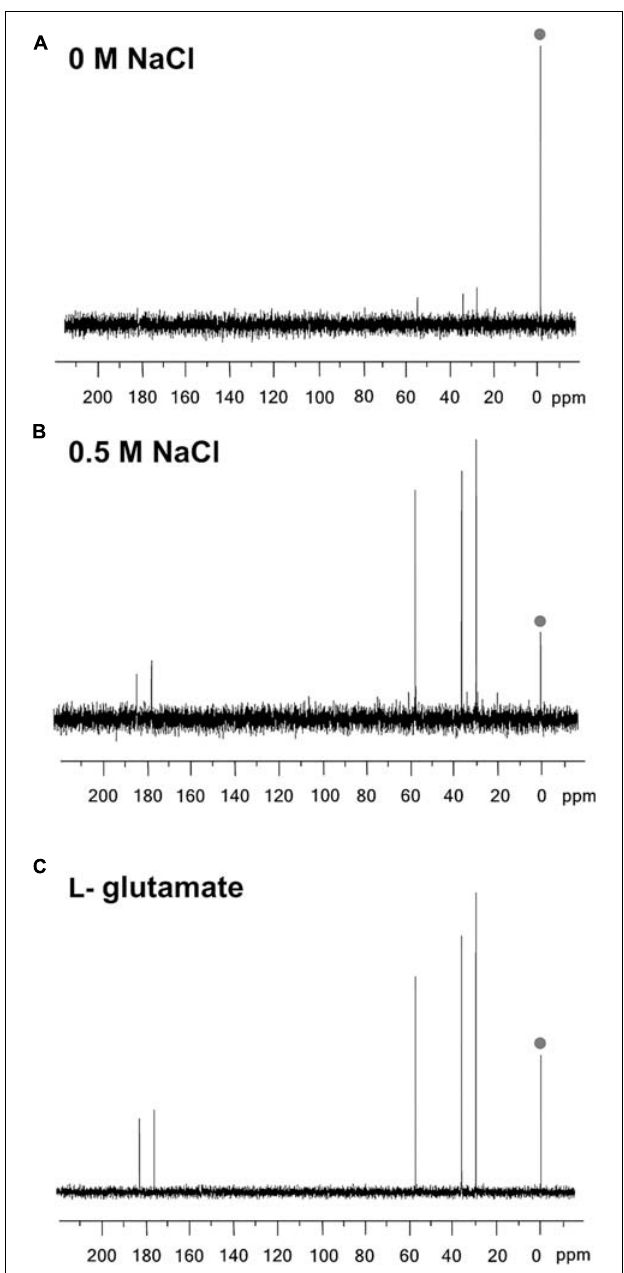
FIGURE 2 | 13 C NMR spectra of ethanolic Bacillus methanolicus MGA3 cell extracts. Cultures of B. methanolicus MGA3 were grown at 50 ◦ C in MVcM in either (A) the absence, or (B) the presence of 0.5 M NaCl until they reached an OD 578 of about 1. Ethanolic cell extracts were prepared and subjected to 13 C-NMR analysis on a Bruker AC300 spectrometer operating at 75 MHz. D 4 -3-(trimethylsilyl)propionate was added to the extracts as an internal standard (its tracing is marked with a dot). (C) The 13 C-NMR spectrum of L-glutamate (25 mg) was recorded as reference.